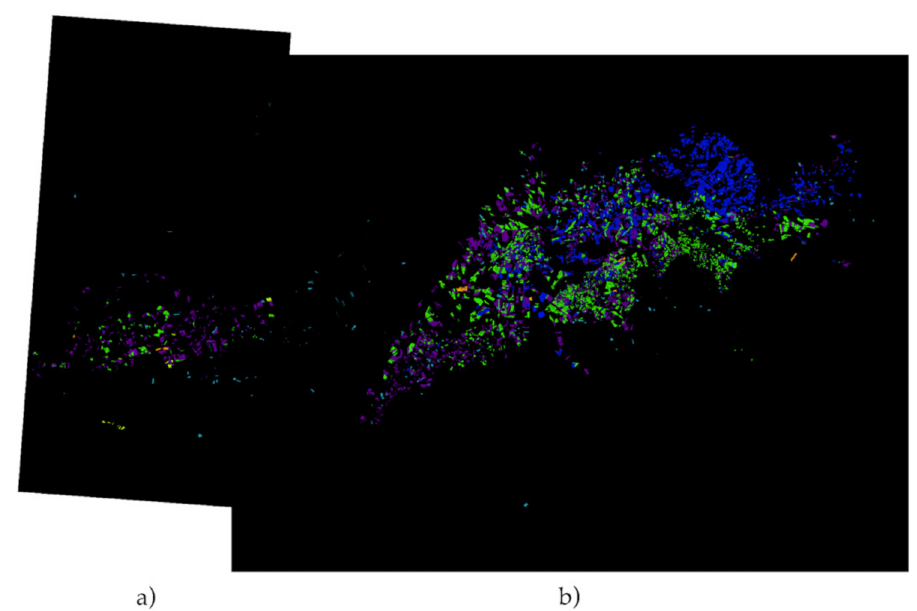
Figure 17. Expected (Ground truth) mask of Zone 29 ( a ) and 30 ( b ). Merida and Don Benito,